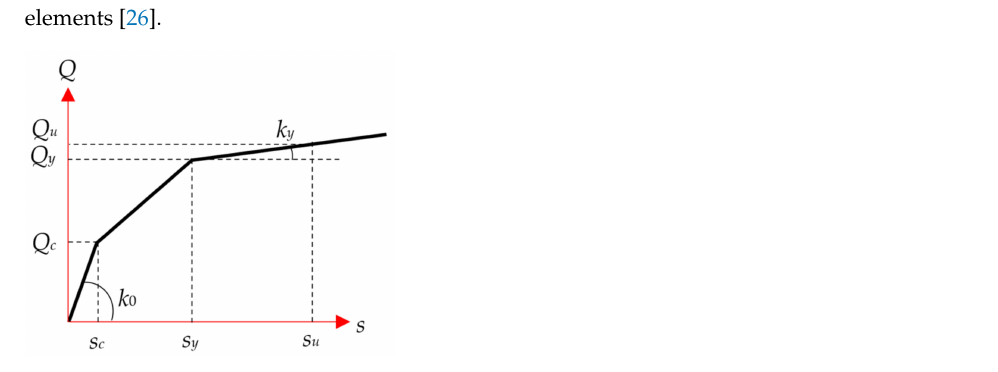
Figure 8. Force-deformation relationship at shear spring for nonlinearity consideration in structural elements [26].